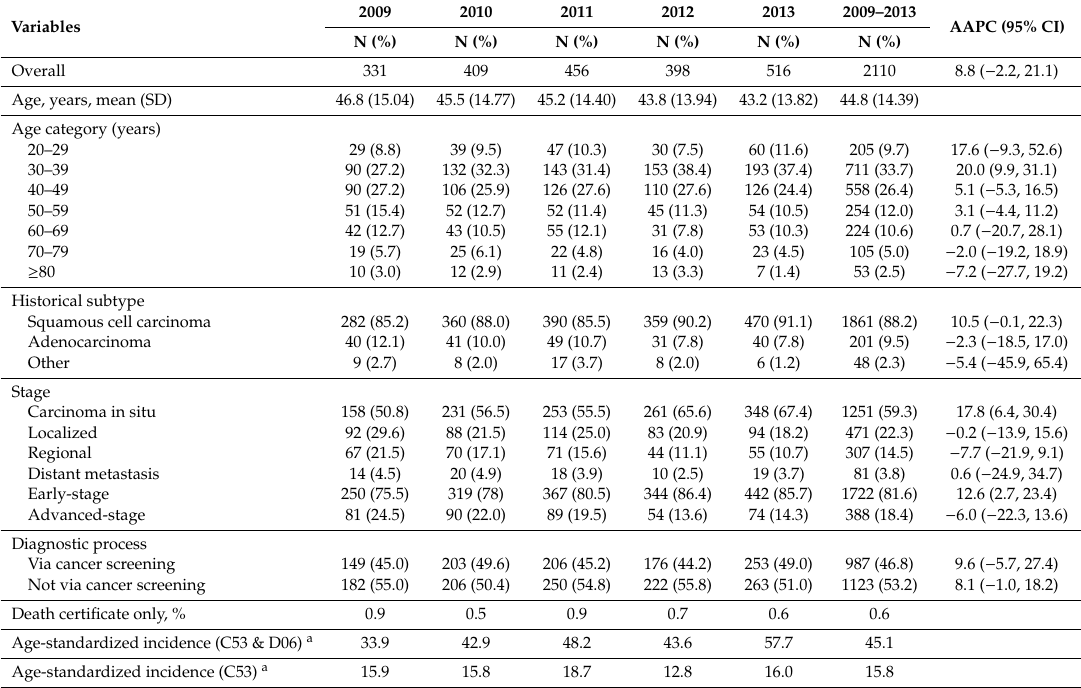
Table 1. Characteristics of cervical cancer registry cases in the Tochigi prefecture (2009–2013).